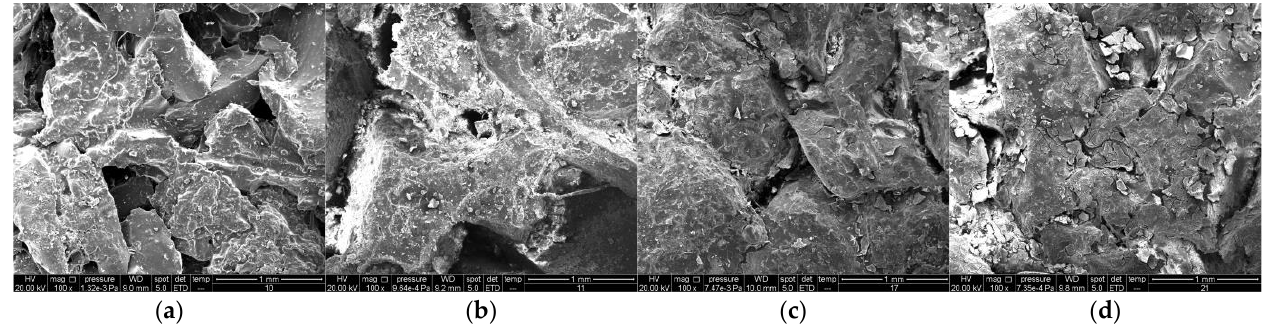
Figure 7. Morphology of the black rubber substrates surfaces with different mass proportions of immobilized TiO 2 compared with the referent (100×): ( a ) referent rubber; ( b ) 2 g of TiO 2 ; ( c ) 4 g of TiO 2 ; and ( d ) 10 g of TiO 2.